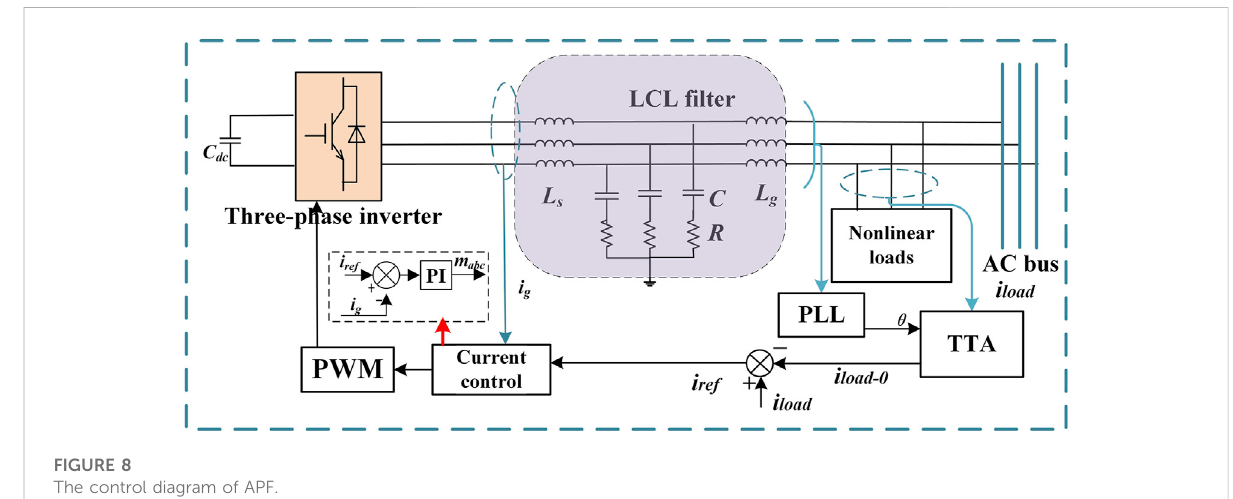
FIGURE 8 The control diagram of